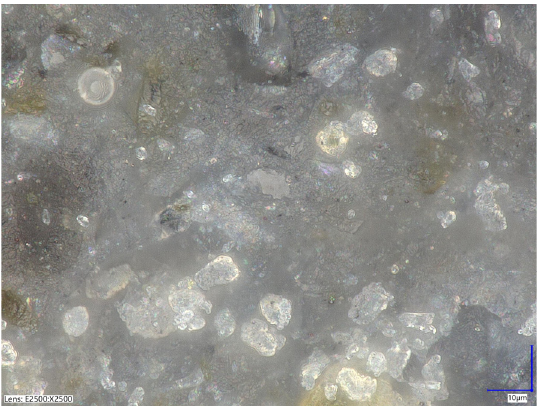
Figure 3. Dense HPC microstructure of with 25% CSF substitution.